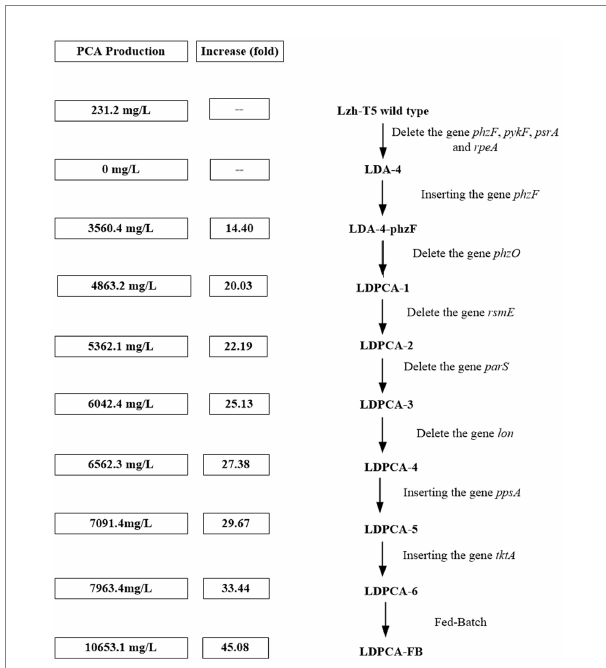
FIGURE 6 A summary of PCA production improve via genetic engineering operations in Pseudomonas chlororaphis.